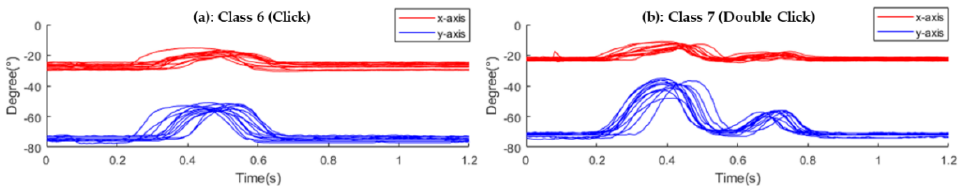
Figure 13. Raw data collected on gestures 6 and 7 from the flex sensor.